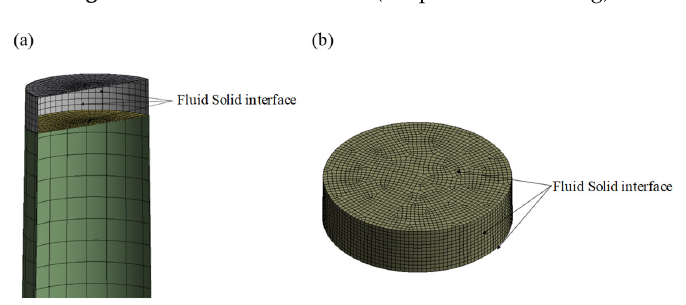
Figure 23. Fluid–solid interface.